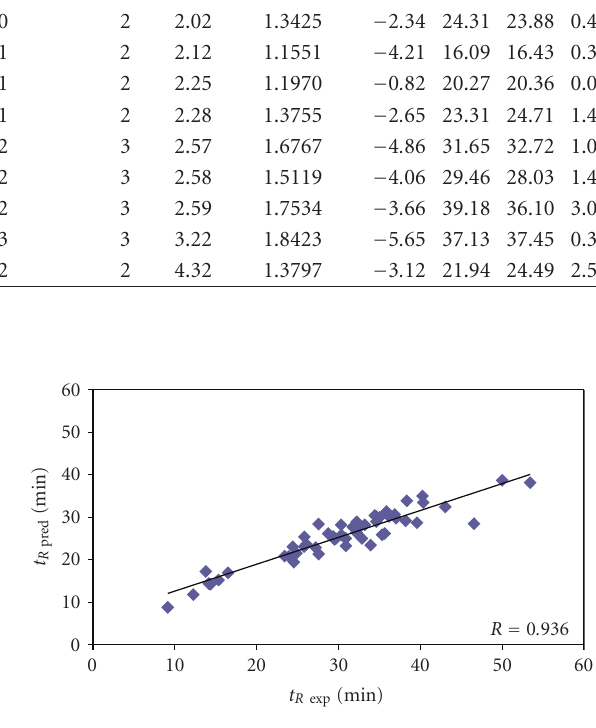
Figure 2: Correlation between experimental and predicted reten- tion times for a set of test peptides obtained from Bacillus subtilis proteome. The proteins were identified on the basis of more than one peptide with X corr above 1.5 ( n =